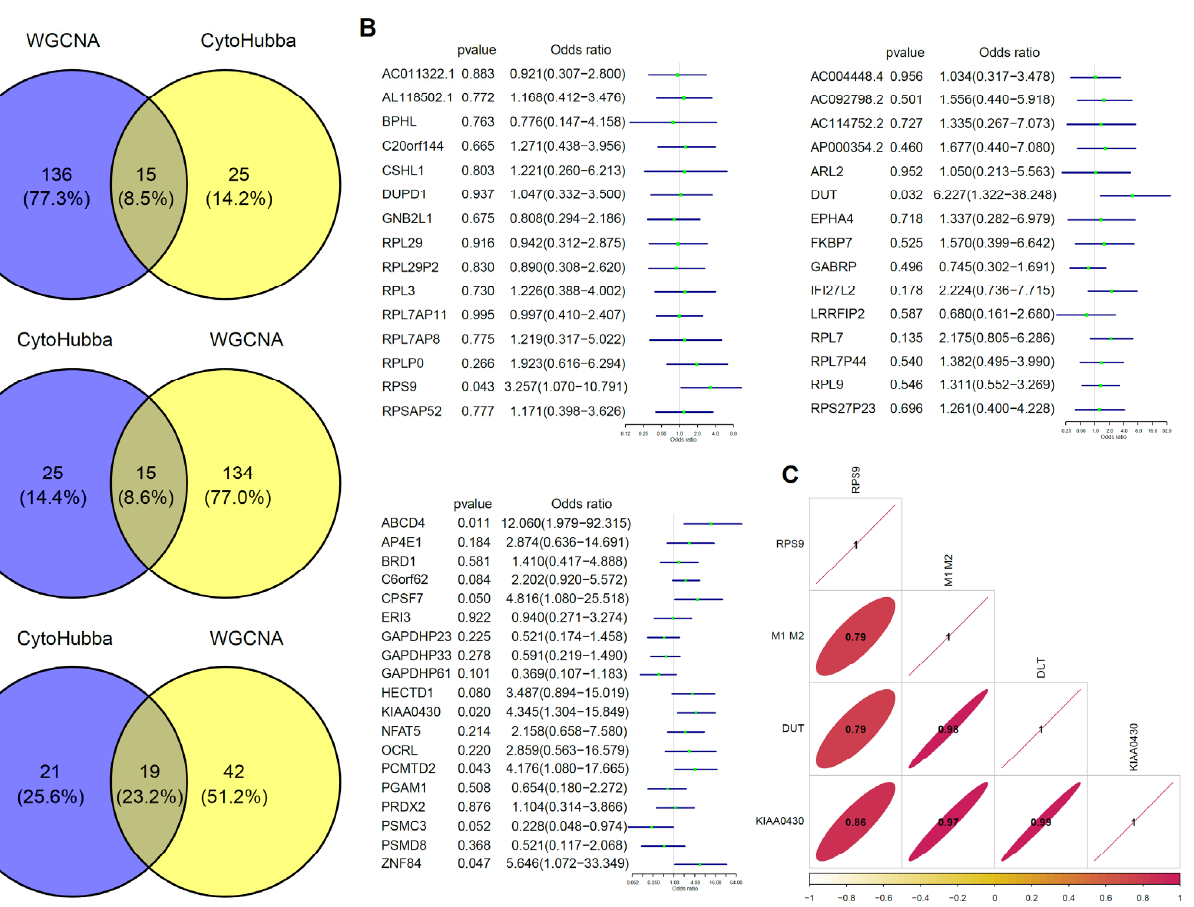
Figure 4. Hub gene selection and verification. ( A ) Venn plot for gene screening. Intersections be- tween modules and hub genes calculated by CytoHubba were selected. ( B ) Univariate analysis of screened genes. RPS9 (OR (Odd rated) = 3.26 (95%CI 1.07–10.97)), DUT (OR = 6.23 (95%CI 1.32– 38.25)), and KIAA0430 (OR = 4.35 (95%CI 1.30–15.85)) genes showed significant benefits for fertility. ( C ) Verification of correlation among hub genes and M1 and M2 macrophages. ( D ) Pathway valida- tion of hub genes in macrophage polarization. RPS9 related genes shows an enrichment in ribosomal and proteasomal pathway ( P adjust = 0 and 0.0102), DUT in ribosomal and lysosome pathway ( P adjust = 0 and 0), and ribosomal and proteasomal ( P adjust = 0 and 5 × 10 − 4 ).